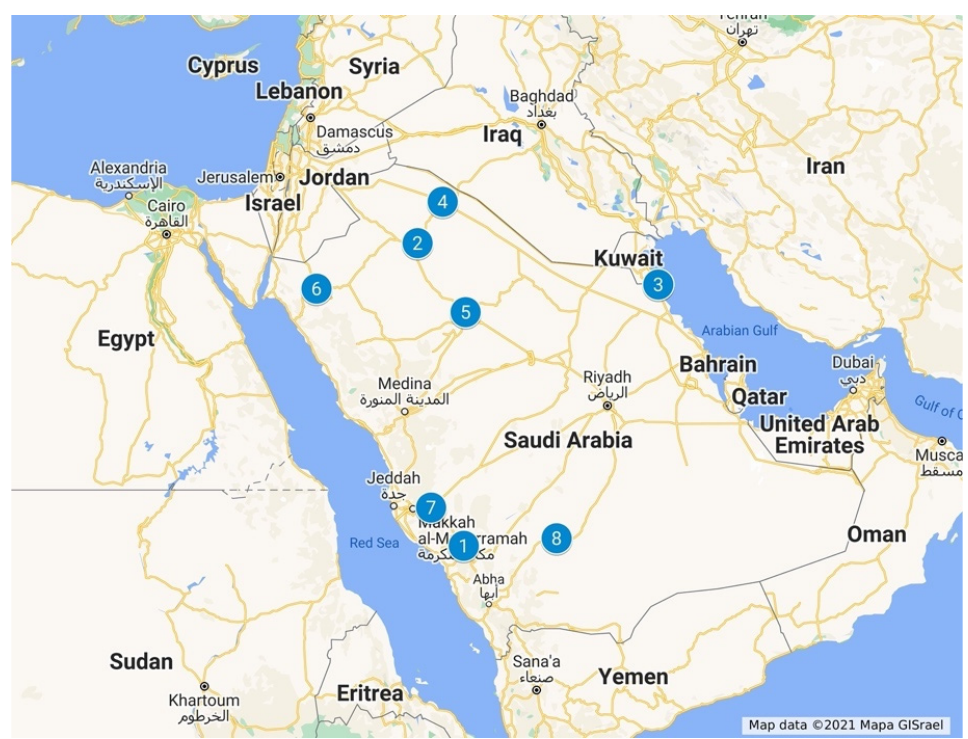
Figure 5. Solar monitoring stations’ locations on a map of Saudi Arabia.